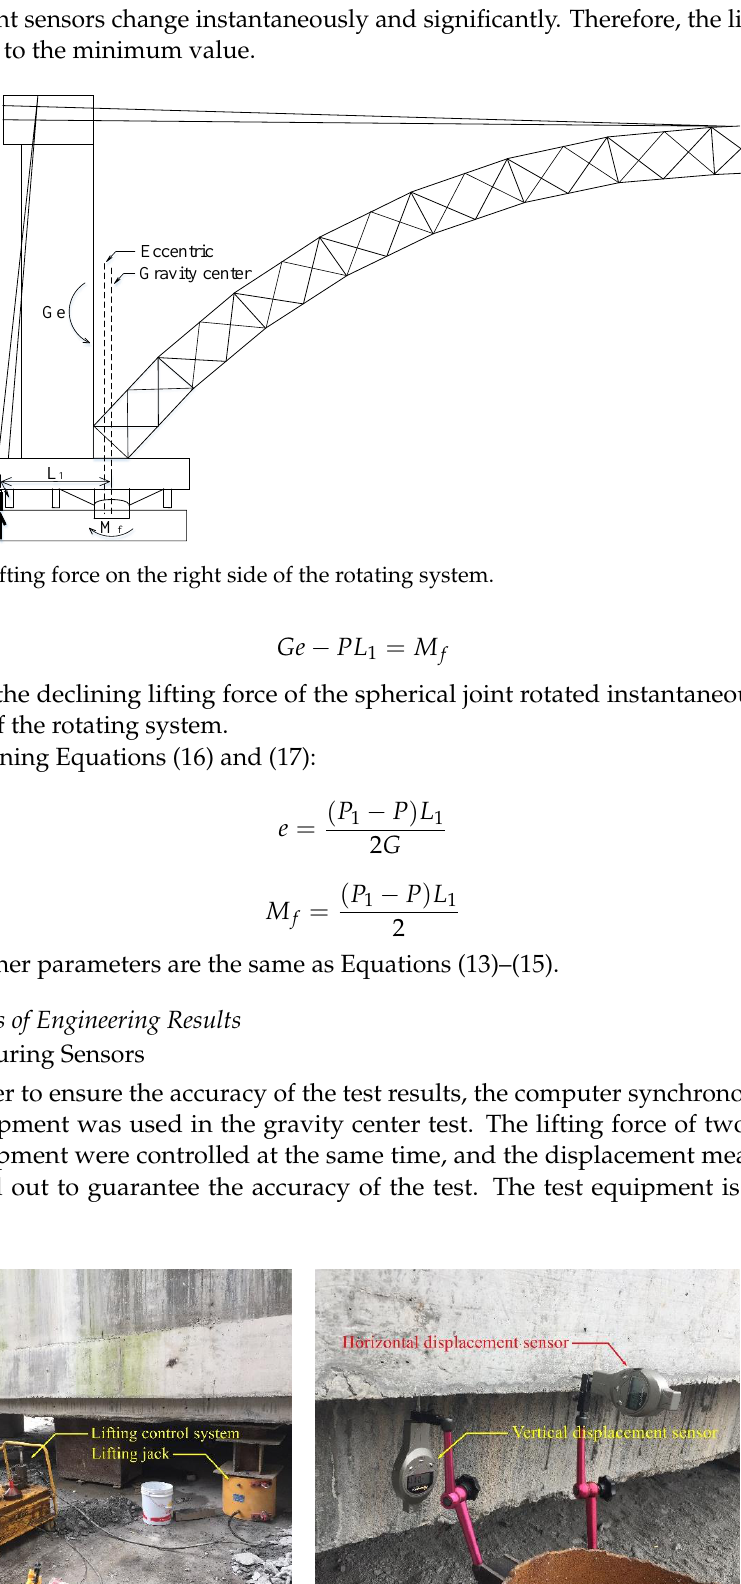
Vertical displacement Horizontal displacement Figure 12. Position of the sensors.